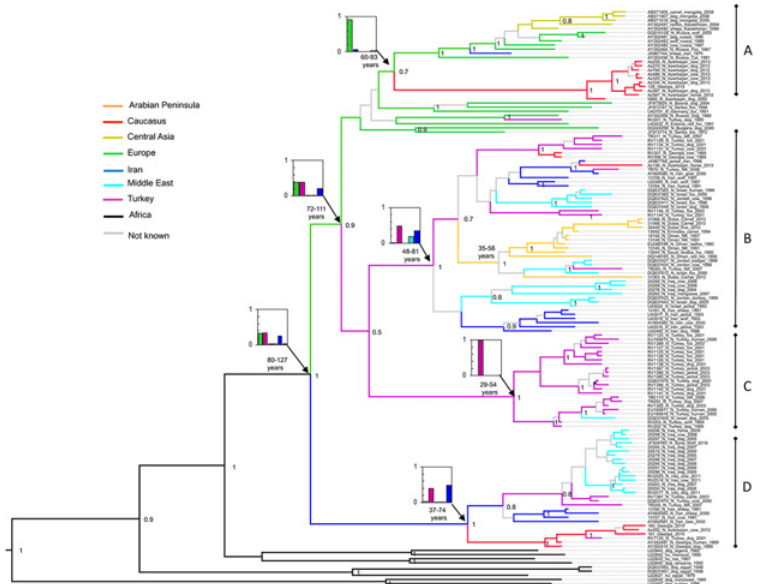
Fig 2. Discrete phylogeographic reconstruction of 139 RABV partial nucleoprotein sequences representing the ‘ Cosmopolitan ’ lineage, in the Middle East and surrounding regions. Model parameters are the same as Fig. 1, with the addition of viral origin location as a defined trait (Europe, Caucasus, Middle East, Arabian Peninsula, Turkey, Iran, Central Asia, and Africa). Branches are coloured by the most probable location of origin of the progeny node. Grey branches are used were the posterior support for the progeny node is low (below 50% probability). Inset are plots of relative probabilities the location of selected nodes coloured by location and the estimates of node ages (95% HPD years since 2014).